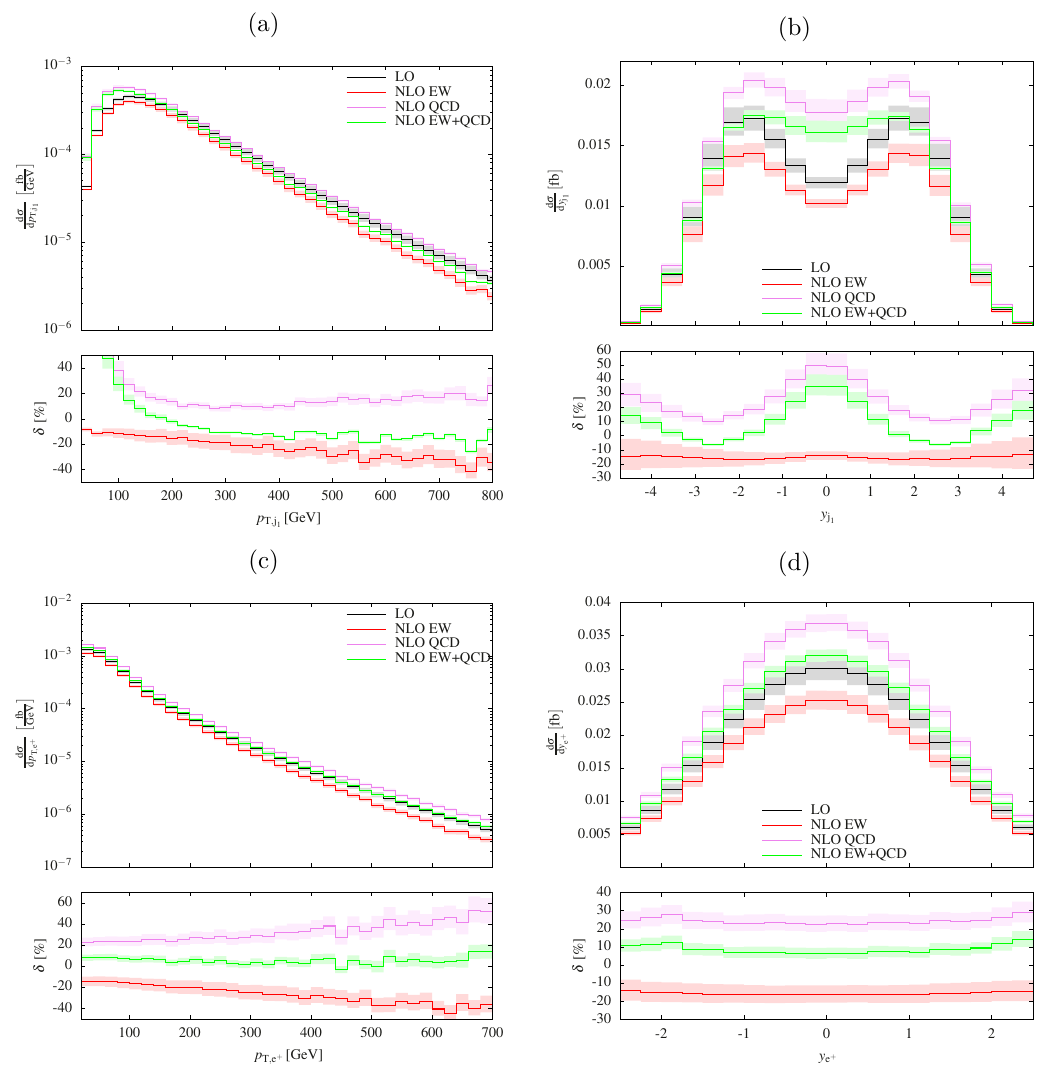
(cid:0) (cid:1) (cid:0) (cid:1) α 6 (LO), O α 7 (NLO EW),